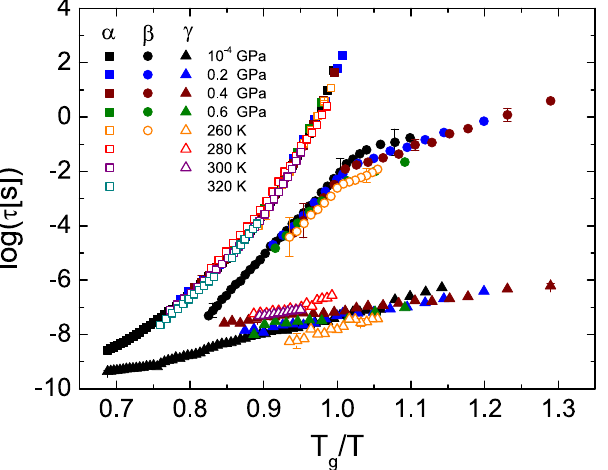
Figure 5. Master plot of the relaxation times for all three relaxation processes in TDZ, as a function of the reciprocal temperature normalized to the glass transition temperature ( T g ). Representative error bars are indicated. See the text for details.